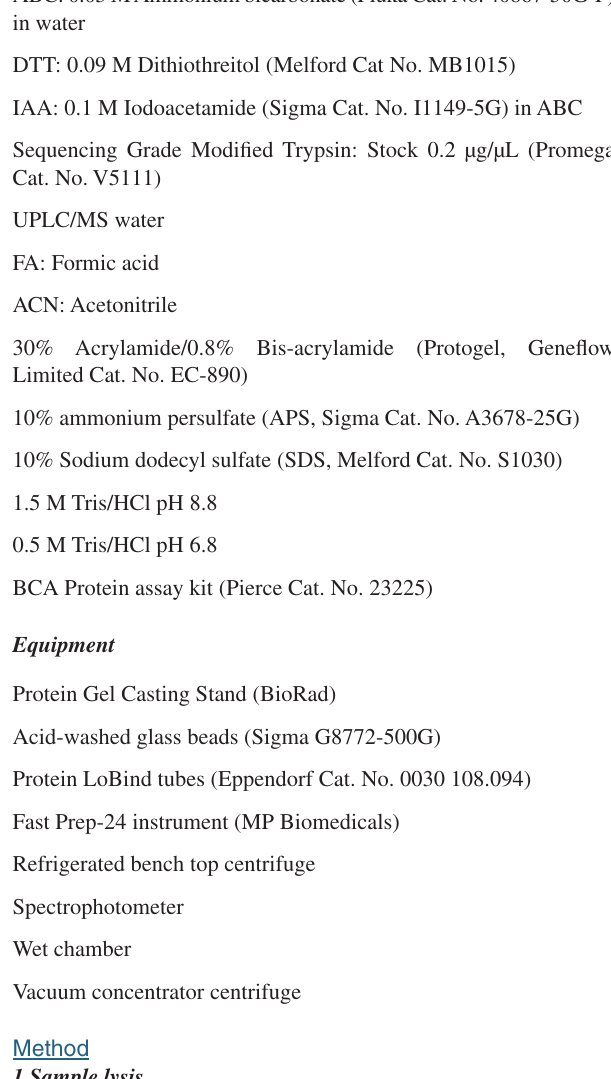
Protocol 2: In-gel digestion in combination with protein extraction in ammonium bicarbonate (ABC) (Adapted from Kaiser, P, Meierhofer, D, Wang, X, Huang, L. Tandem affinity purification combined with mass spectrometry